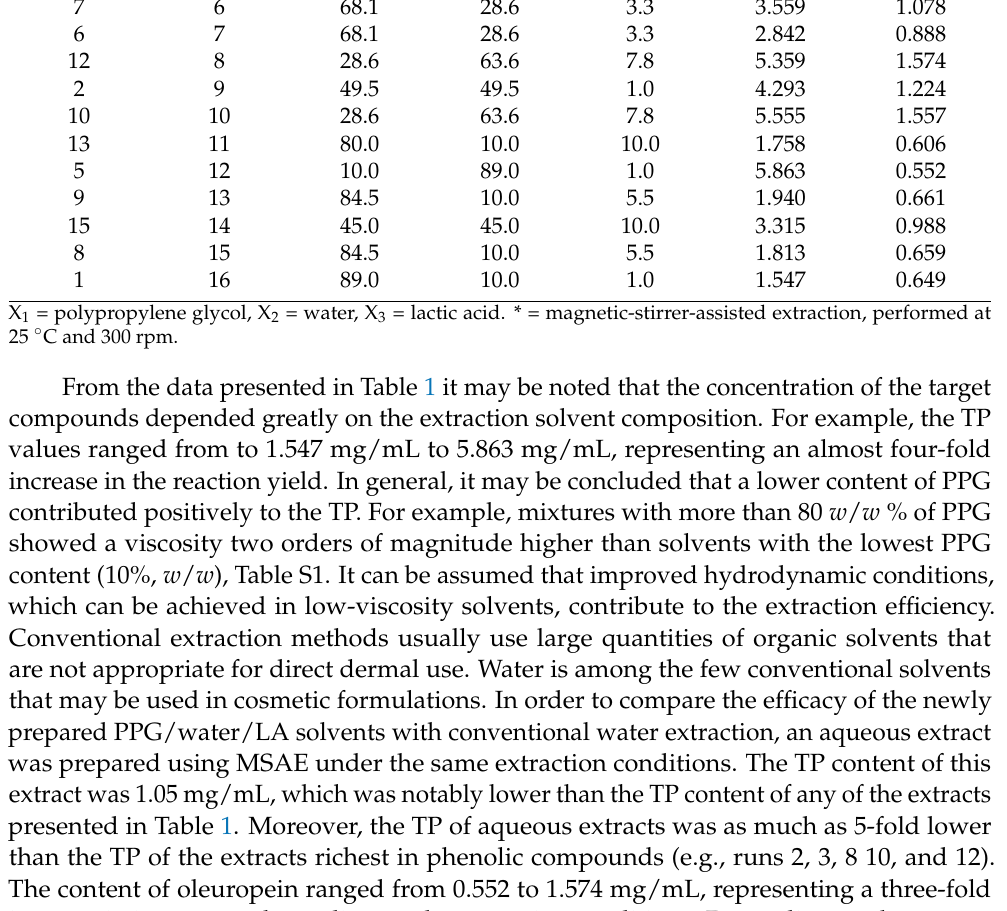
X 1 X 2 X 3 TP Oleuropein (%, w / w ) (%, w / w ) (%, w / w ) (mg/mL)